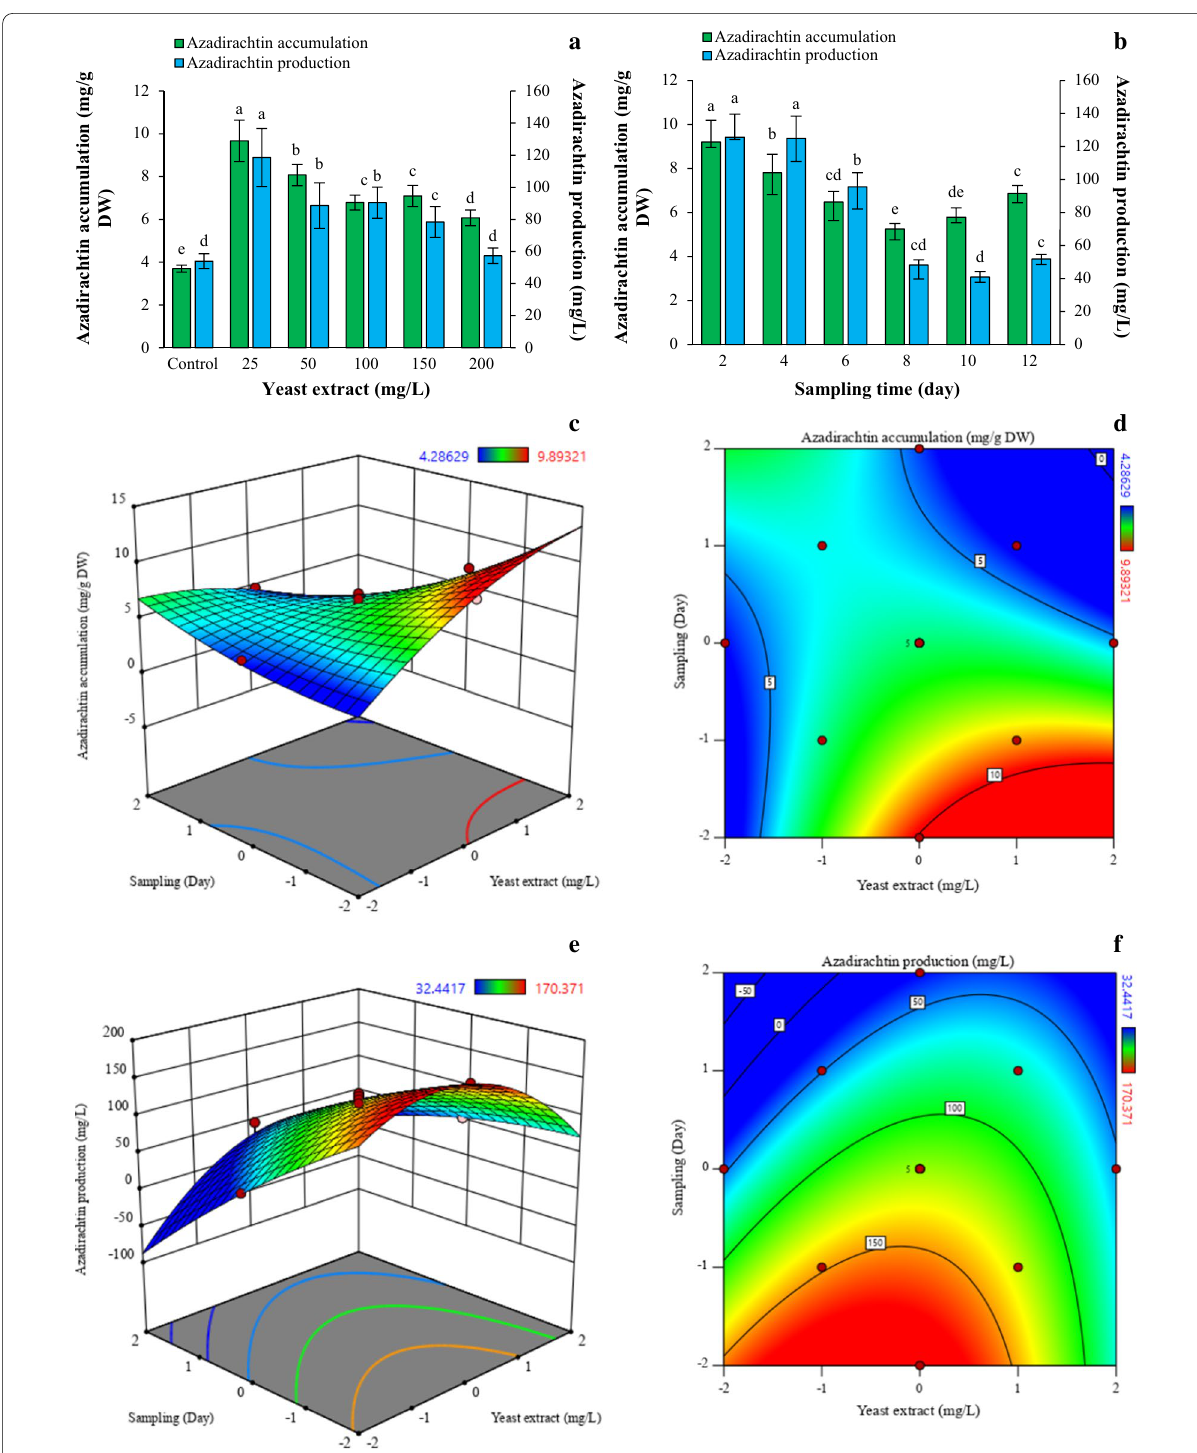
Fig. 2 The effect of different concentrations of yeast extract and sampling times ( a , b ) and response surface and contour plots for azadirachtin accumulation ( c , d ) and azadirachtin production ( e , f